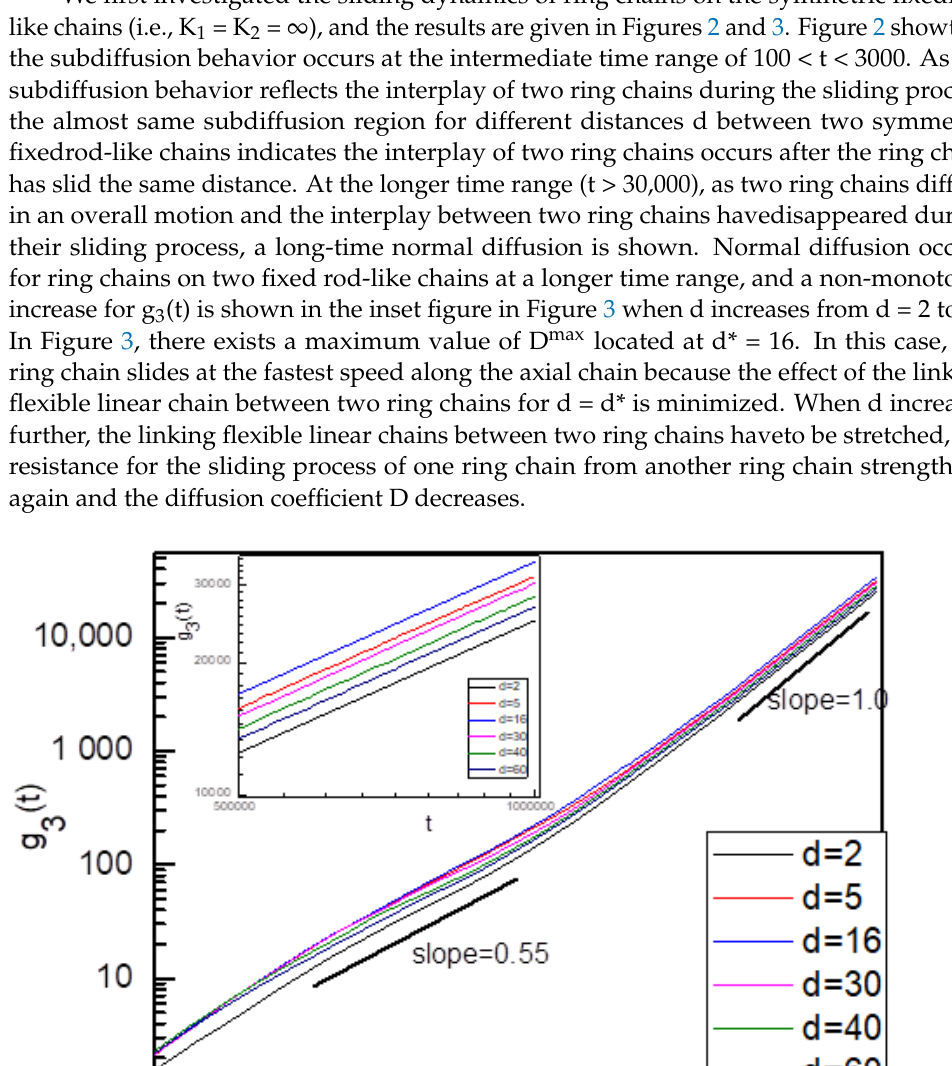
Figure 3. Diffusion coefficient Dof ring chain on the symmetricfixed rod-like chains(K 1 = K 2 = ∞ ) with different distances d between two symmetricfixed rod-like chains.